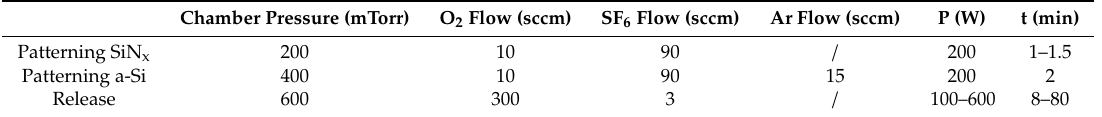
Table 1. Parameters of barrel etching processes for cap patterning and